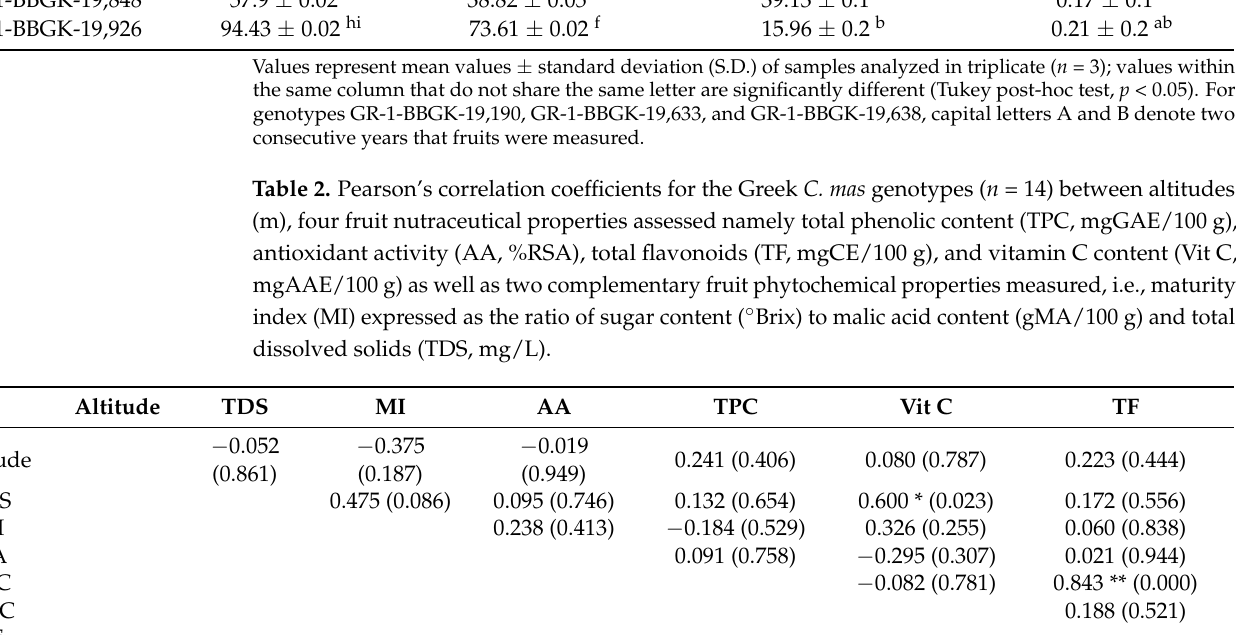
Respective p -values are shown in parentheses. ** Correlation is significant at the 0.01 level (2-tailed). * Correlation is significant at the 0.05 level (2-tailed). Antioxidant activity (AA) among all assessed genotypes ranged from 55.46 %RSA